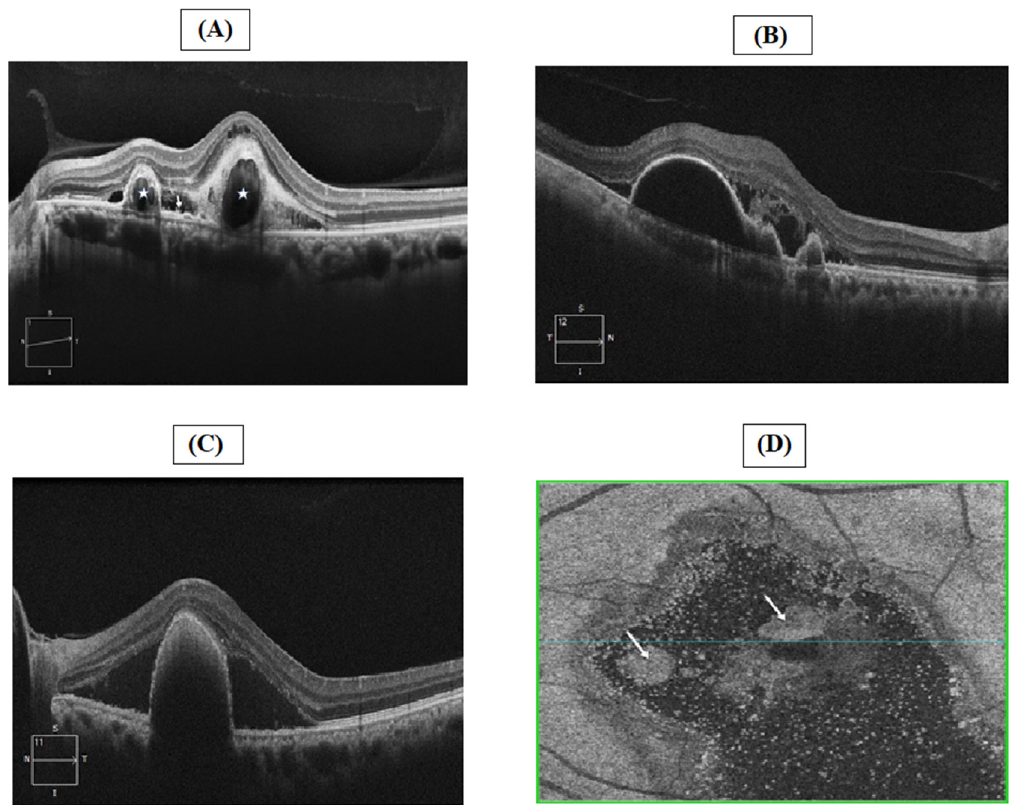
Figure 4. OCT images in eyes with PCV (( A ) sharp-peaked PEDs with ring shaped (white stars), double-layer sign (white arrow), subretinal fluid and thicken choroid; ( B ) Multiple lobular PED (white arrows), subretinal fluid and hemorrhage [high reflective material]; ( C ) A sharp peak PED with hyper-reflective material at the top underneath the RPE; ( D ) En face OCT: retinal elevation (white arrow)).